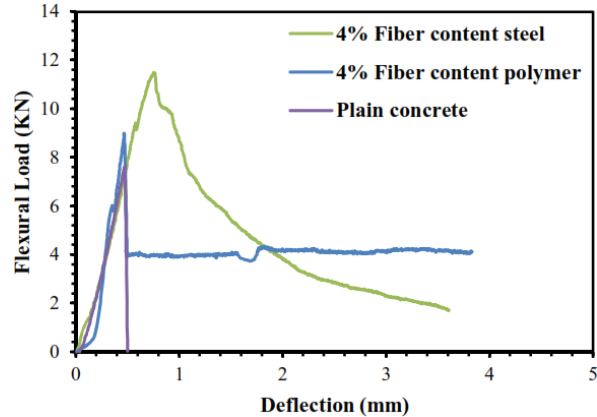
Figure 6: Average flexural load- deflection curves of the tested